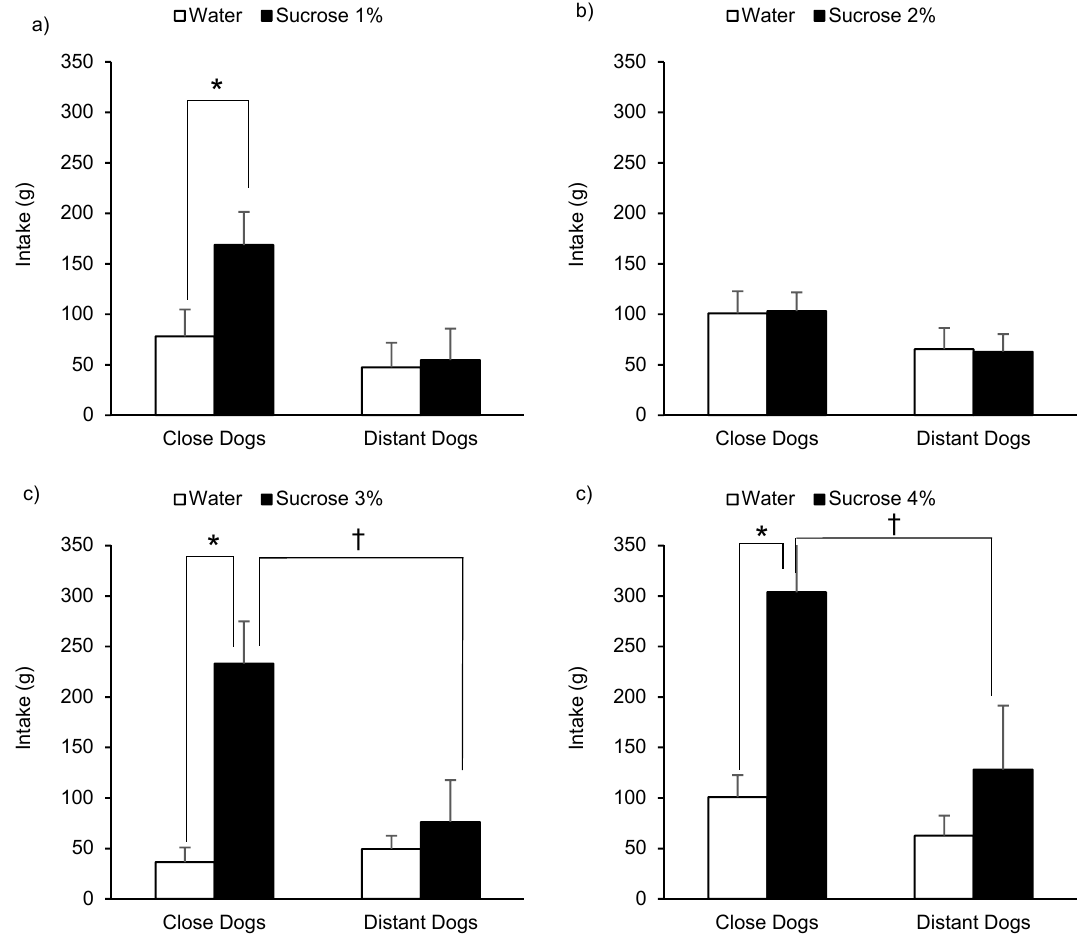
Figure 2. Consumption (least square means + standard error) of kennelled dogs in front of 1% ( a ), 2% ( b ), 3% ( c ), and 4% ( d ) sucrose and water solutions during a 20 min two-choice preference test according to the human-approach test results (close or distant) previously assigned (* p < 0.05; † p < 0.1).